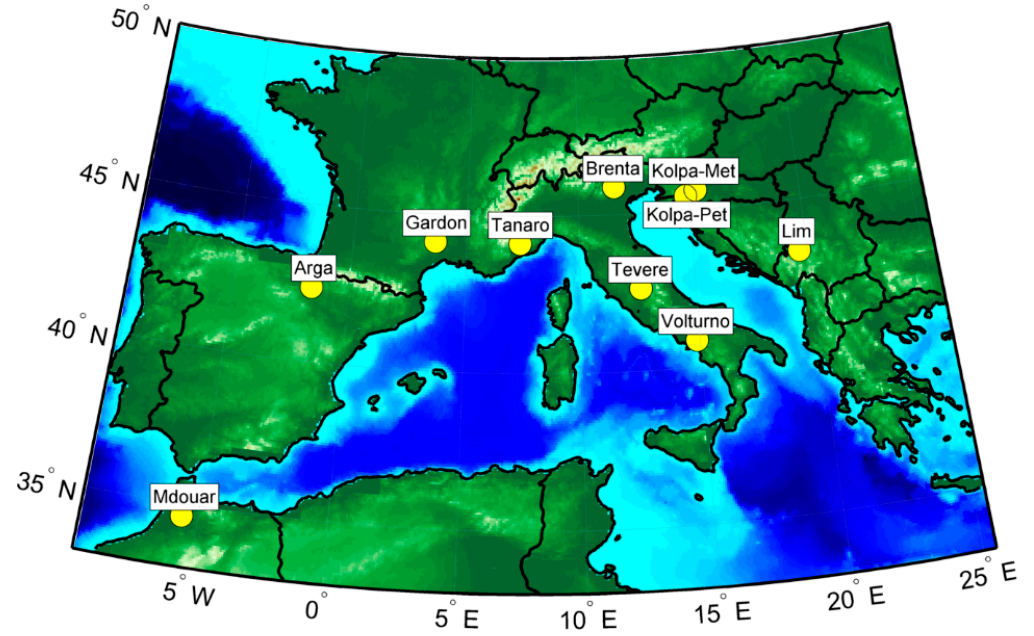
Figure 1. Location of the investigated catchments in the Mediterranean area. Table 1. Main characteristics of the investigated catchments. Cfb: temperate warm summer, Dfb: Cold Warm summer; Csa: Temperate dry and hot summer; Csb: Temperate dry and warm summer according to the Köppen classication.